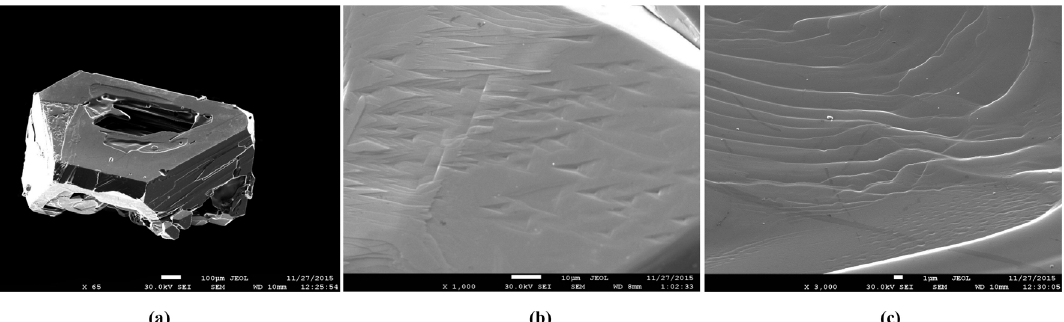
melts in a contact with sulfur 2